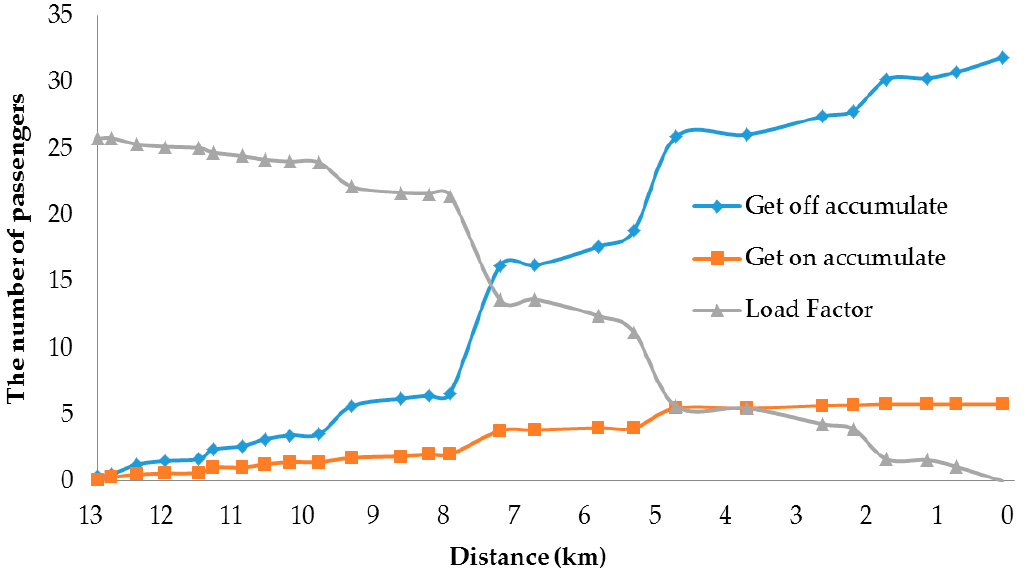
Figure 5. Outbound Passenger Load Profile from Rama 2 T-junction to Samaedam Terminal.